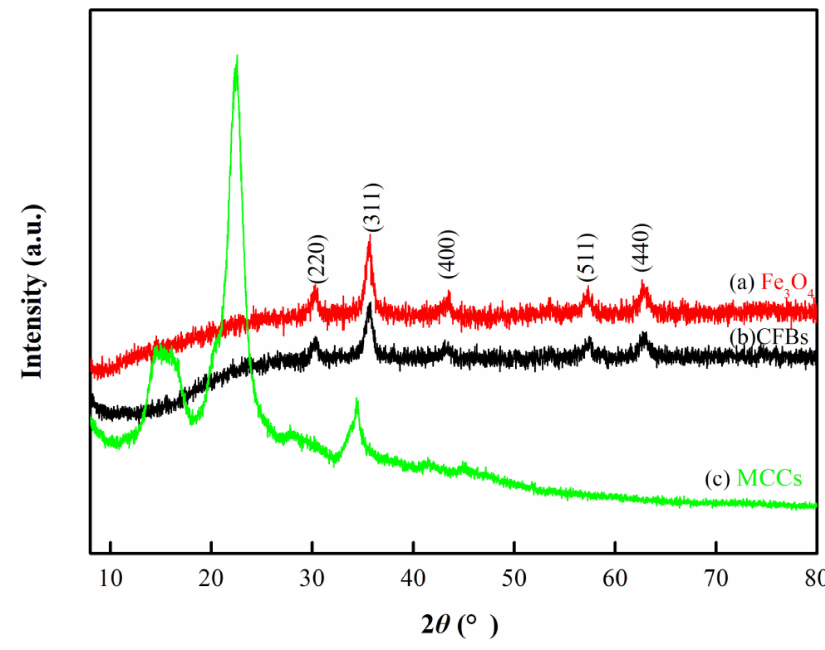
Figure 1. XRD patterns of ( a ) Fe 3 O 4 , ( b ) CFBs, and ( c ) MCC.